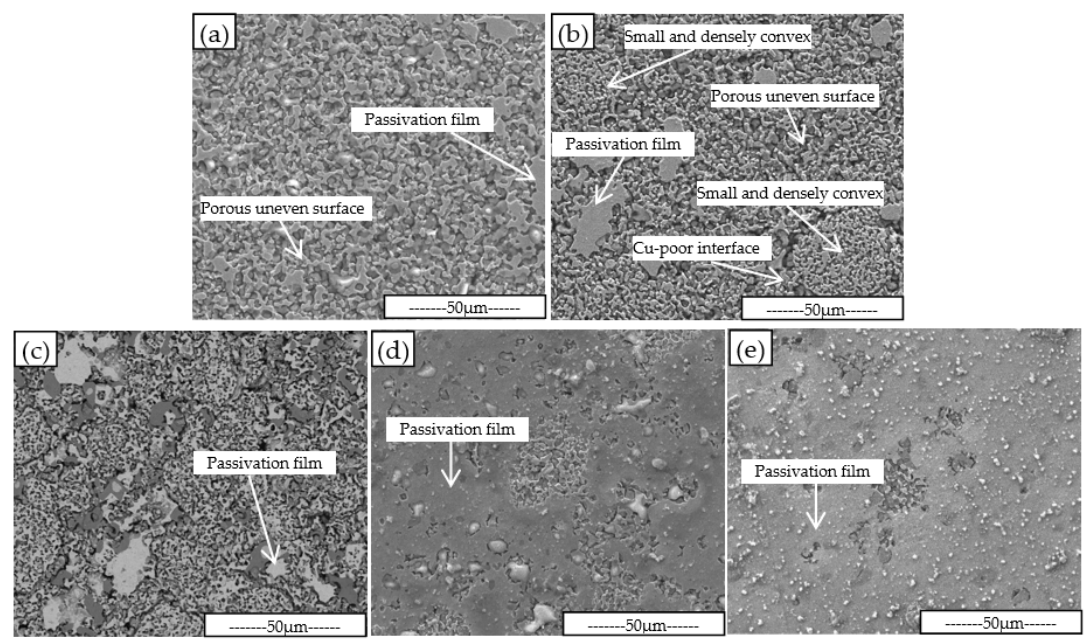
Figure 5. SEM surface morphology of alloys with ( a ) 0%, ( b ) 5%, ( c ) 8%, ( d ) 11%, and ( e ) 14% Cu-Sn addition after electrochemical test.